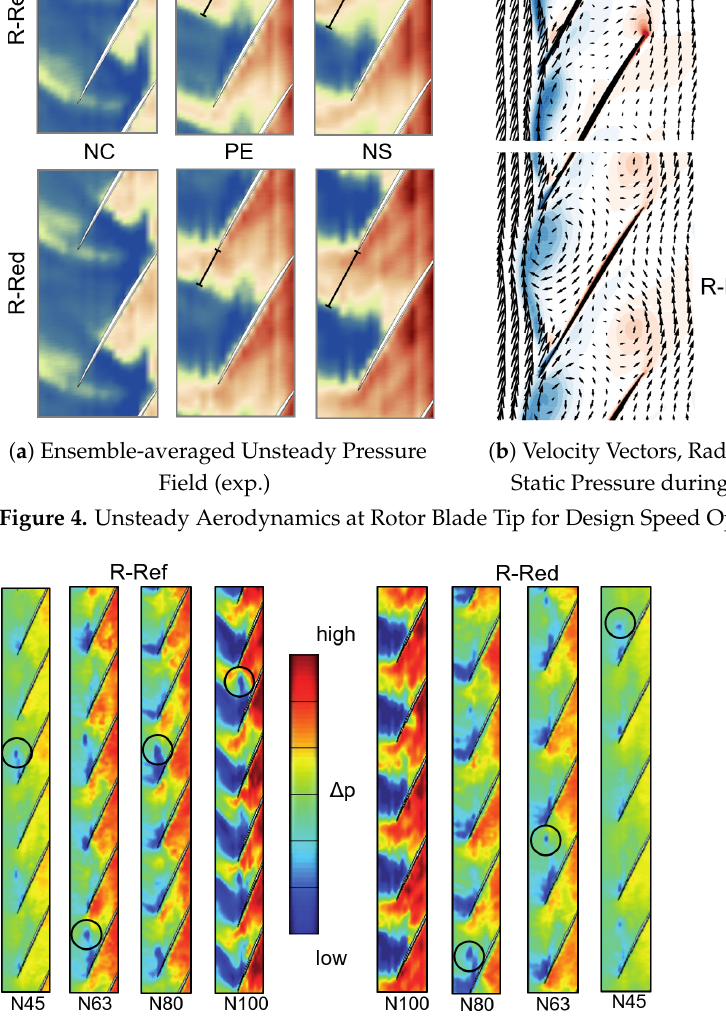
Figure 5. Unsteady Pressure Field at Blade Tip for Near Stall Operation